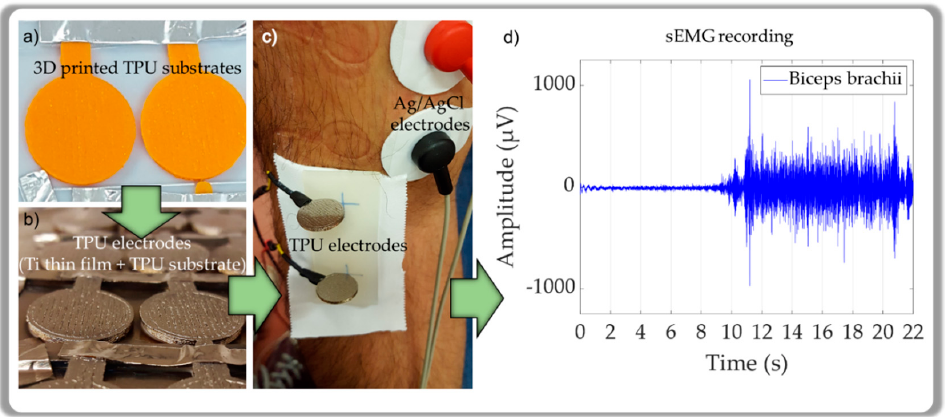
Figure 1. Thermoplastic polyurethane (TPU) electrode after: ( a ) 3D printing process, ( b ) thin film deposition, and ( c ) surface electromyography (sEMG) measurements; ( d ) exemplifies an sEMG recording from the Biceps brachii muscle.